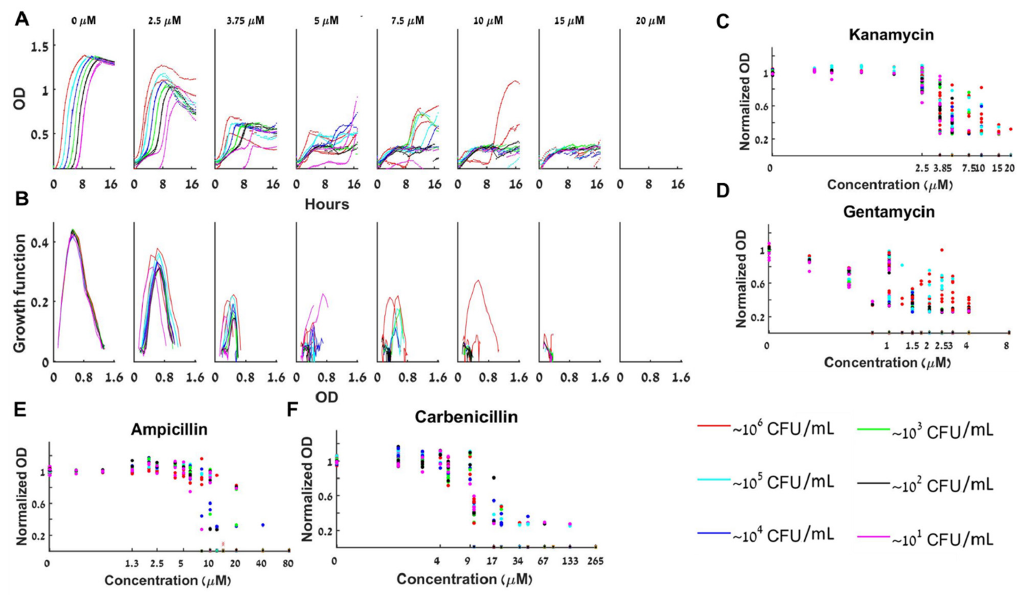
Figure 5. Bacteria grown with β‐ lactam or aminoglycoside antibiotics exhibit complex bistable dynamics. ( A ) The growth of different initial loads for a fixed initial concentration of kanamycin has different forms and thus their growth curves do not collapse to a single growth function ( B ). Collective results of normalized maximal capacity are shown for ( C ) six repeats with kanamycin. ( D ) Four repeats with gentamycin. ( E ) Four repeats with ampicillin. ( F ) Four repeats with carbenicillin. The maximal capacities are load and dose dependent. See also separate experimental results in Figure S5.